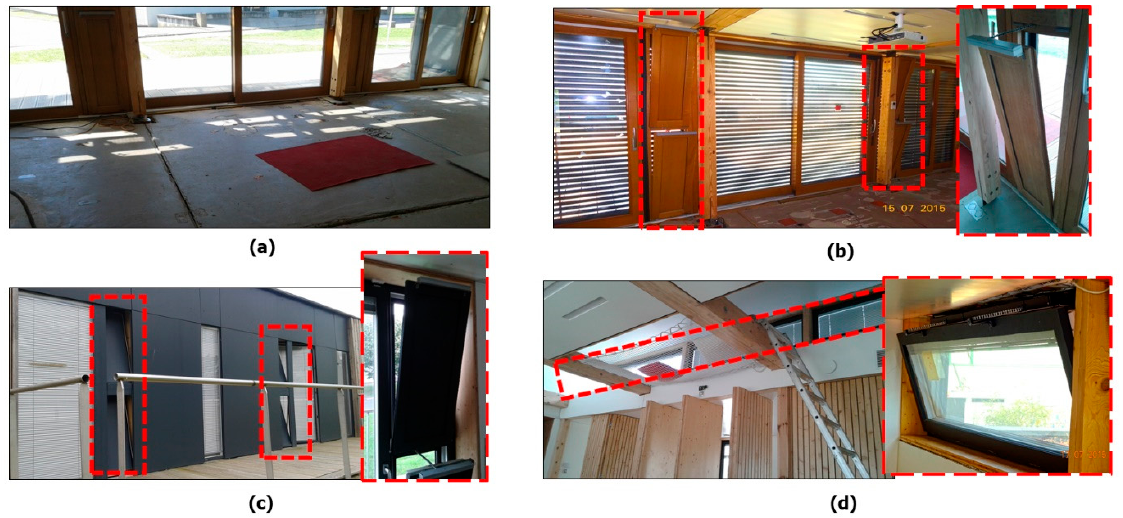
Figure 1. Architectural features: ( a ) floor concrete slab, ( b ) programmable solar shades and natural ventilation openings (inside red squares) on the south glazed façade, ( c ) the north facade, ( d ) and the shed roof.